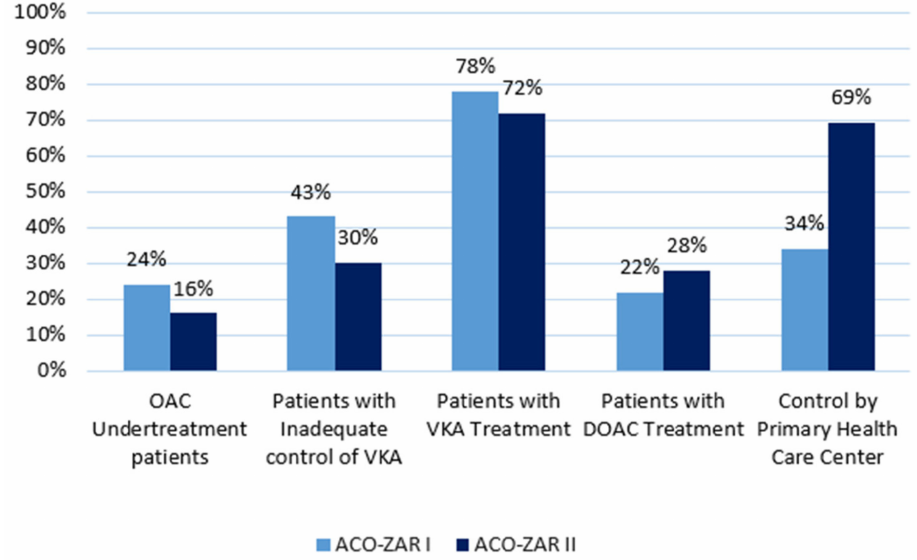
Figure 2. A comparison of the results obtained between ACO-ZAR I and ACO-ZAR